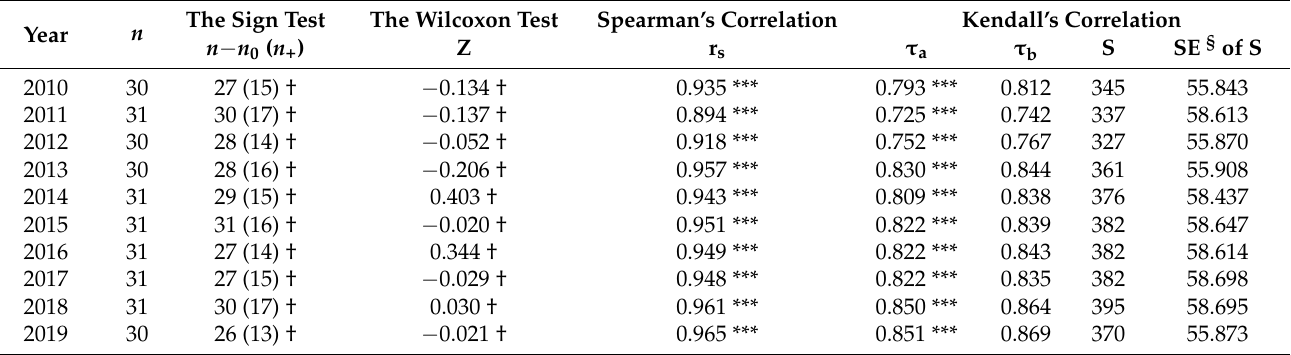
Table 4. Results of the sign test, the Wilcoxon test and Spearman’s and Kendall’s correlation tests for LE ranks for the total population and the older subpopulation in 2010–2019.